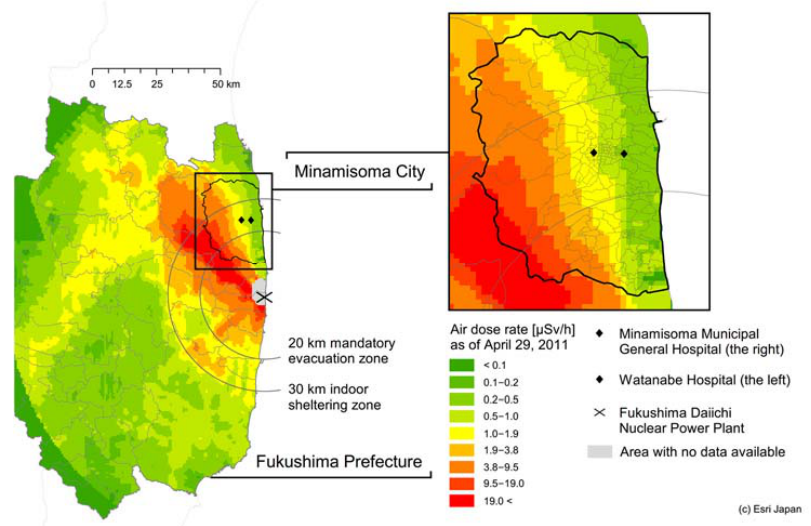
Figure 1. Location of Minamisoma City relative to the Fukushima Daiichi Nuclear Power Plant.